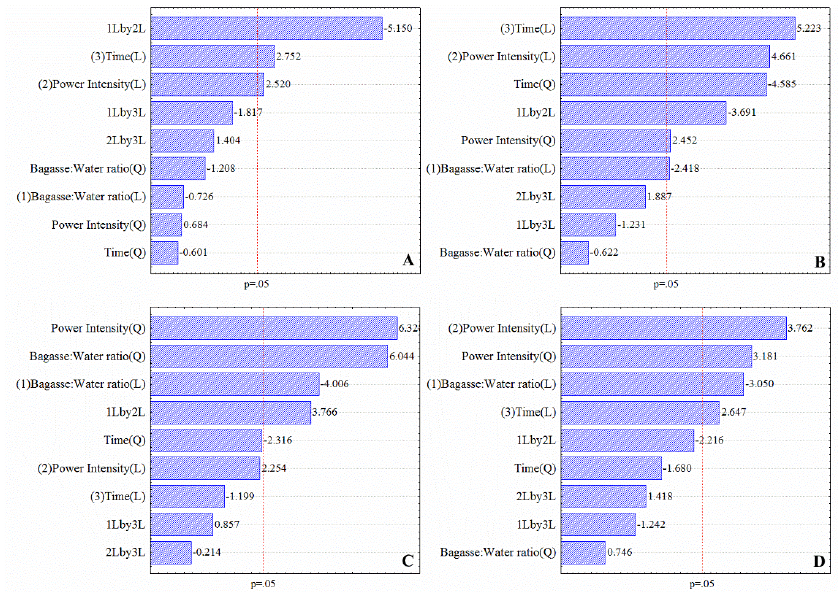
Figure 3. Pareto charts for the effect of sonication on luminosity (L) ( A ); hue angle (h°) ( B ); Chroma ( ∆ C) ( C ); and total color difference ( ∆ E) ( D ) of sonicated cashew apple bagasse (C.A.B.).